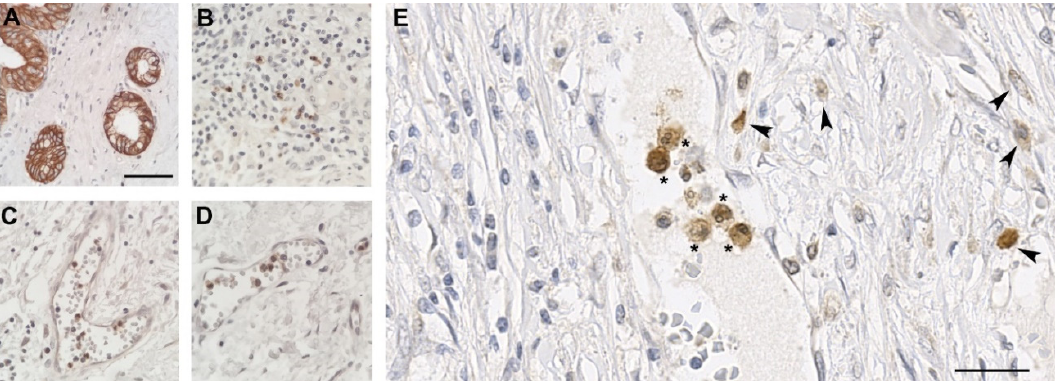
Figure 4. ADAM8 positive neutrophils located in tumor stromal post-capillary venules. ( A ), ADAM8 staining in duct-like structures; ( B ), ADAM8 staining in PDAC tumor stroma adjacent to duct-like structures reveals mainly ADAM8 + neutrophils; ( C ) and ( D ) overview venules in tumor areas with ADAM8 + neutrophils. ( E ), detailed view of venules with ADAM8 + neutrophils in vessels (asterisks) and adjacent infiltrated neutrophils (arrowheads) in a representative PDAC section. Scale bar in ( A ), valid for ( A – D ), 120 µ m; Scale bar in ( E ), 55 µ m.